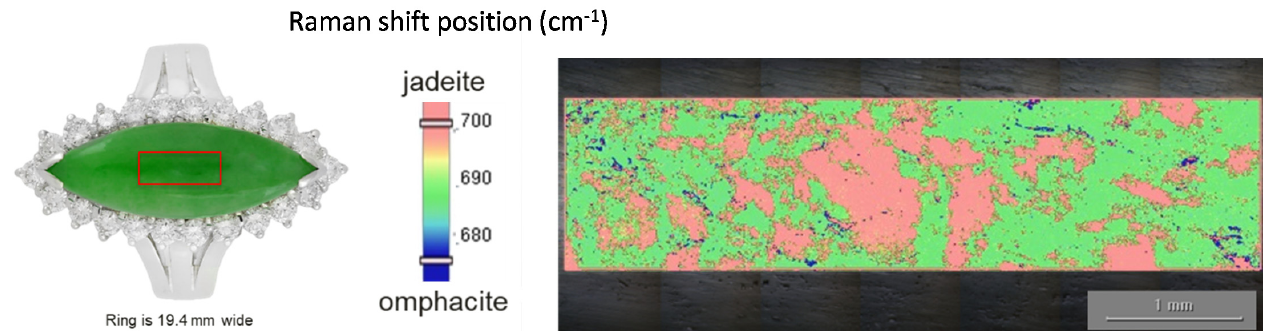
Figure 27. Raman map of a “jadeite” ring (left) shows a mixture of mineral compositions. The false color map (right) ranges in color from jadeite (pink) to omphacite (blue) based on the position of the 678–700 cm − 1 primary Raman peak.